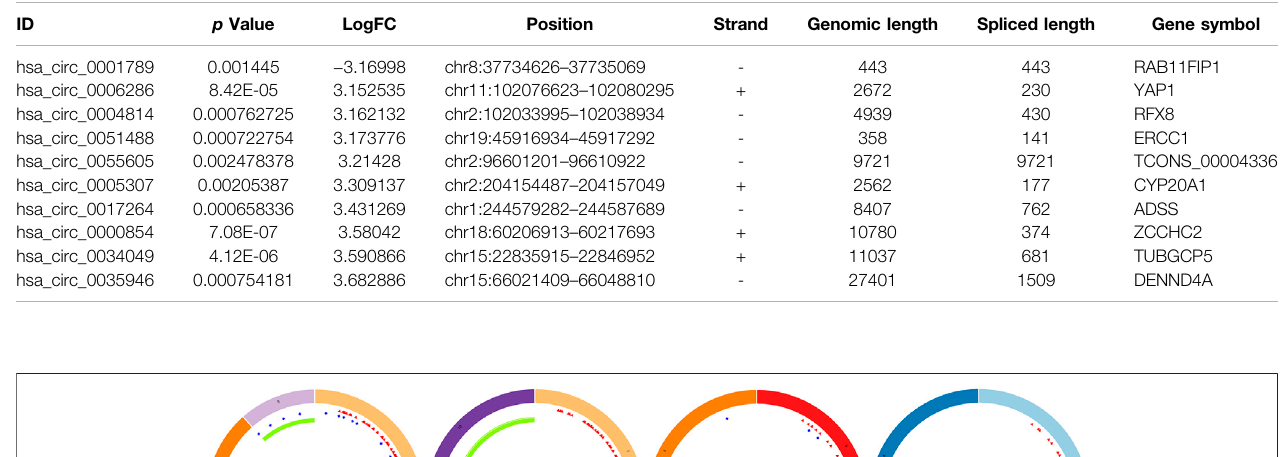
TABLE 3 | Basic information for the top 10 differentially expressed circRNAs with a |logFoldChange| > 3.